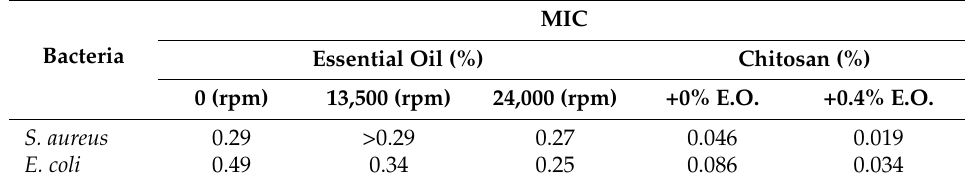
Table 5. Minimum inhibitory concentration (MIC) of emulsified pomelo peel oil and chitosan against S. aureus and E. coli .